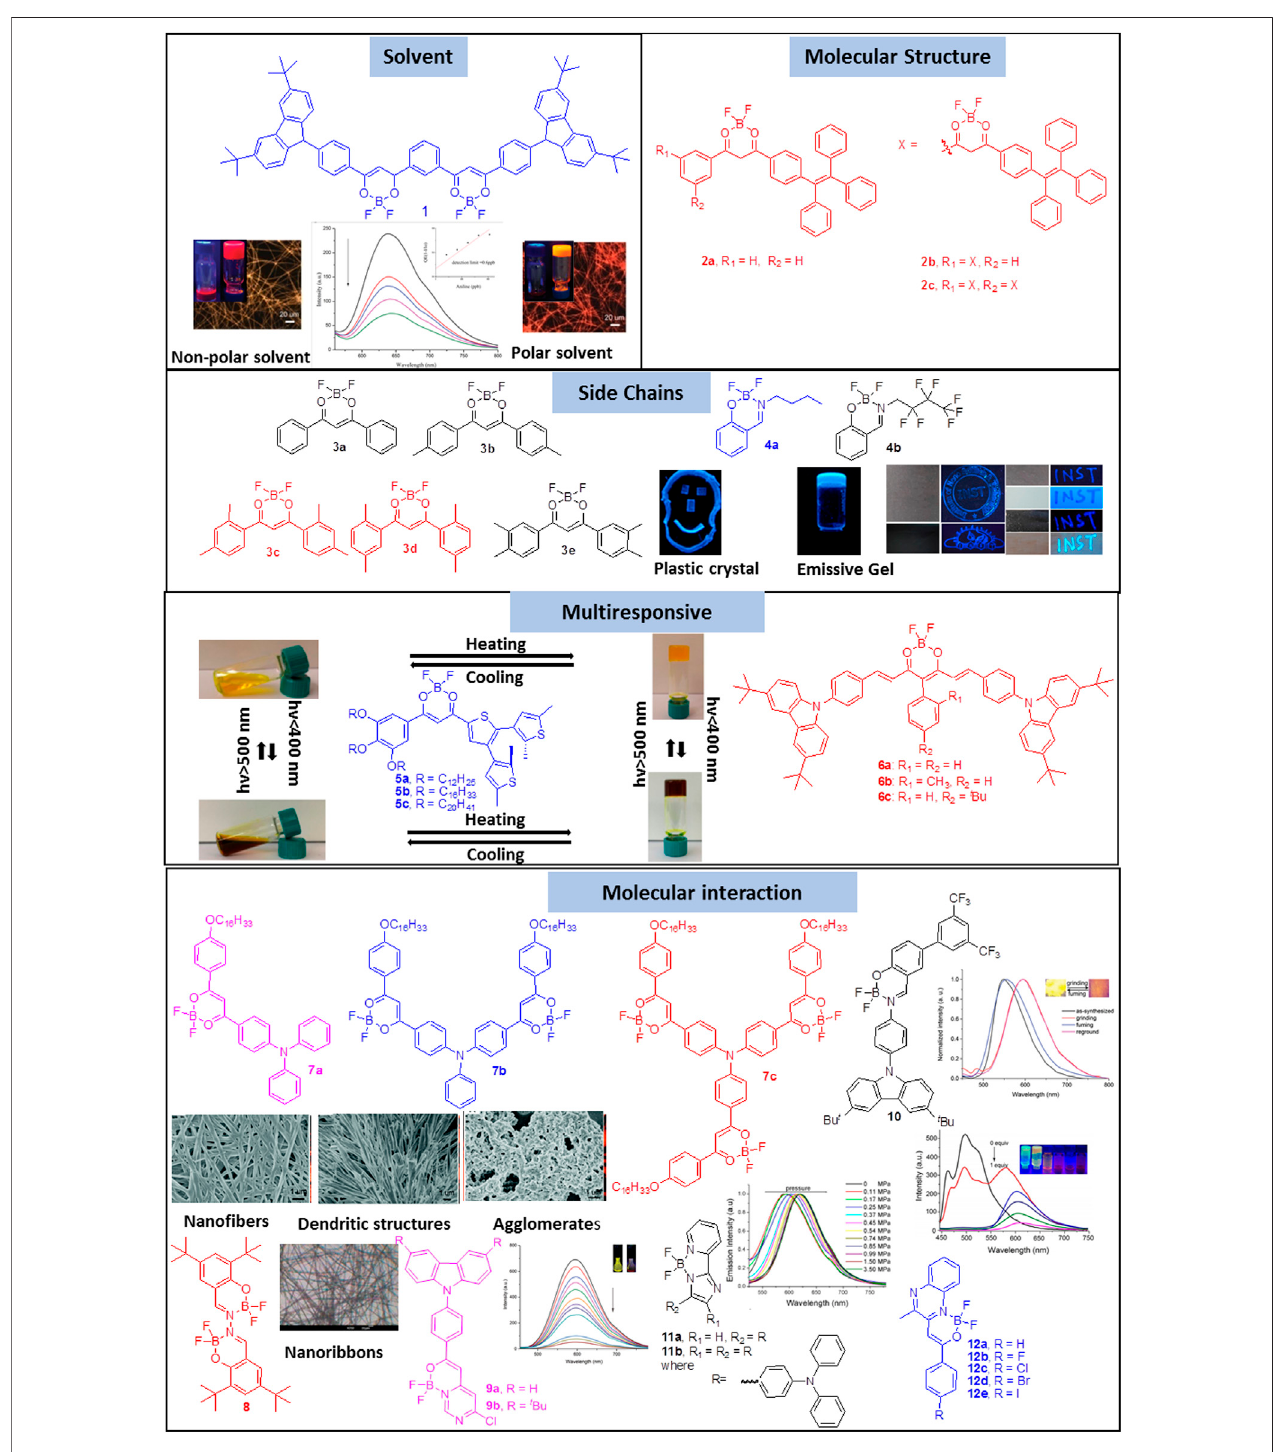
FIGURE1| Gelationofboron-di fl uoridecompoundsonthebasisoftheeffectofsolvent,molecularstructure,effectofsubstituentsandintermolecularinteractions. Reproduced withpermission fromSun etal.,2018,copyright2018RoyalSociety ofChemistry.Reproduced fromNaim etal.,2021,copyright2021AmericanChemical Society. Reproduced from Wong et al., 2017, copyright 2017 American Chemical Society. Reproduced with permission from Qian et al., 2015, copyright 2015 Royal Society ofChemistry.Reproduced withpermission fromGonget al.,2015,copyright2015RoyalSocietyofChemistry. Reproduced withpermission fromMiet al., 2018, copyright 2018 Royal Society of Chemistry. Reproduced with permission from Sun et al., 2017, copyright 2017 Royal Society of Chemistry. Reproduced with permission from Wang et al., 2017, copyright 2017 WILEY-VCH. Reproduced with permission from Wu et al., 2017, copyright 2017 WILEY-VCH.